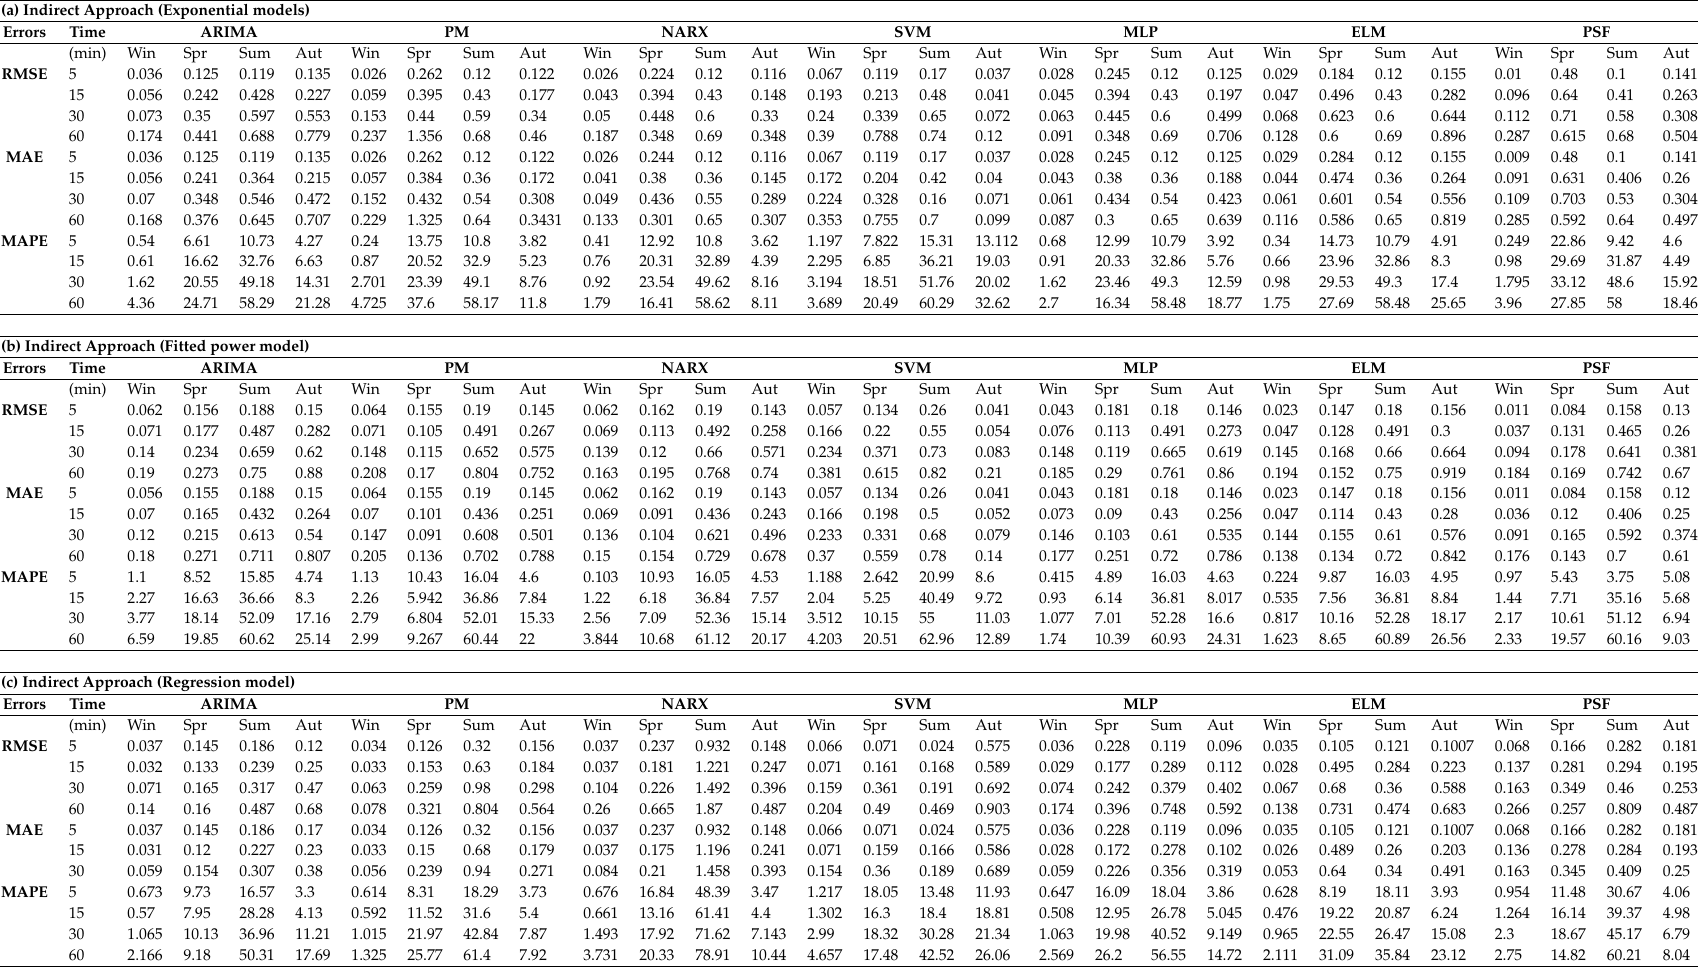
Table A6. Comparison of wind-power prediction results with ( a ) exponential model; ( b ) fitted-power model; and ( c ) regression model. (a) Indirect Approach (Exponential models) Errors Time